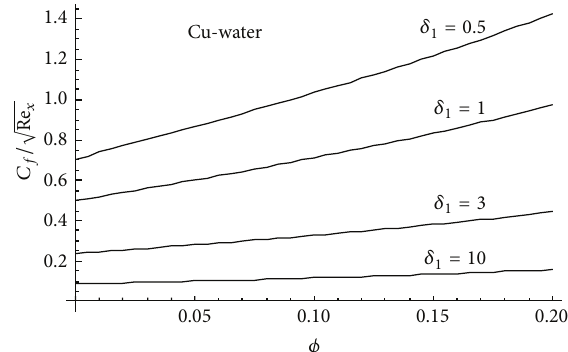
Figure 8: Effect of the first slip 𝛿 1 on reduced skin friction coefficient as a function of 0 ≤ 𝜙 ≤ 0.2 for Cu-water nanoparticles when 𝑃𝑟 = 6.2 , = 0 . 𝑠 = 0.5 , and 𝛿 2